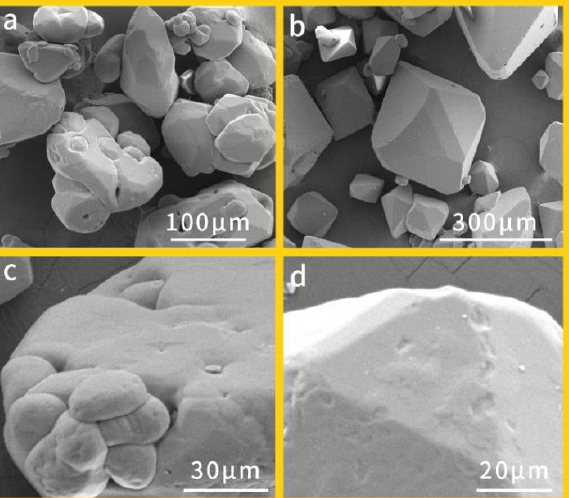
Figure 1. Apparent morphology images of different RDX crystals: ( a ) raw RDX (400×), ( b ) H-RDX (200×), ( c ) raw RDX (1500×), and ( d ) H-RDX (2000×). The authors apologize for any inconvenience caused and state that the scientific conclusions are unaffected. The original publication has also been